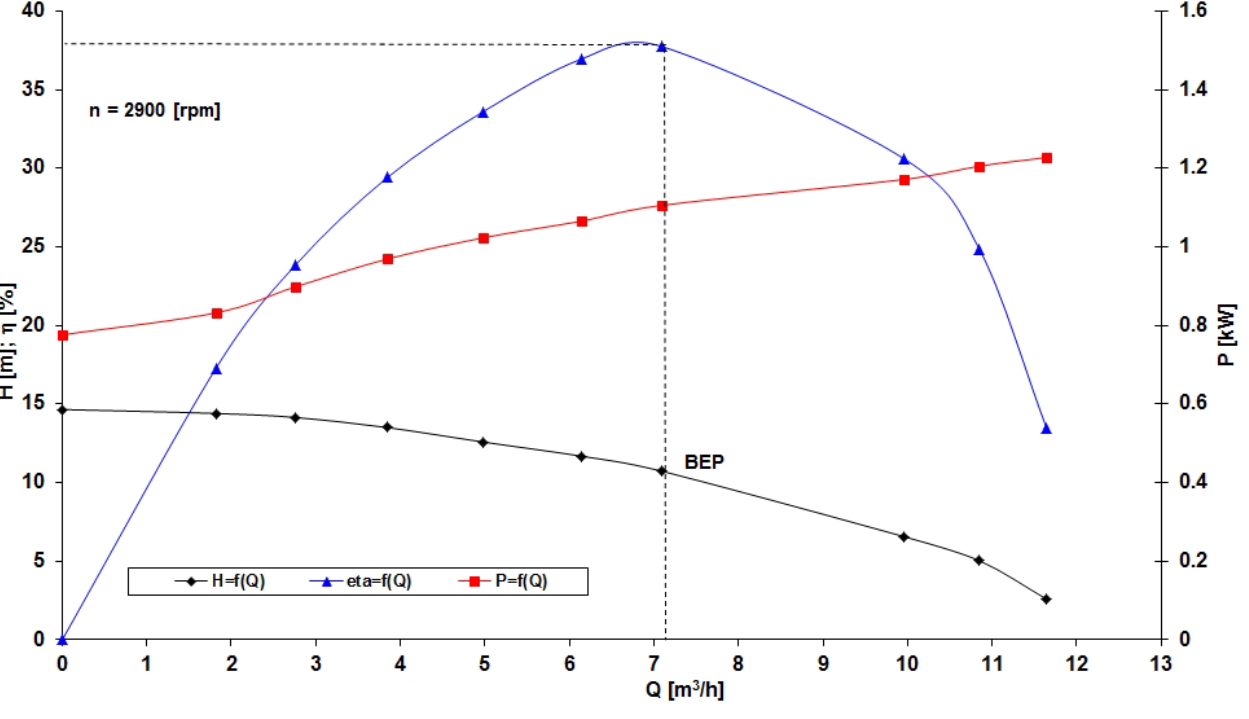
Figure 9. Scheme of supplying air during the visualization tests: 1 — air quantity control valve; 2 — air supplying pipe; 3 —shut- off valve; 4 — suction pipe; 5 — model pump; 6 —discharge pipe.